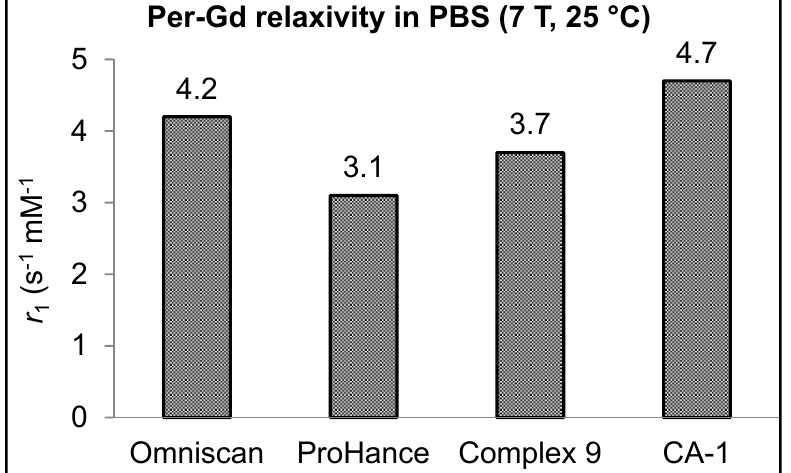
Figure 4. Comparison of the per-Gd r clinically used CAs; Omniscan and ProHance.